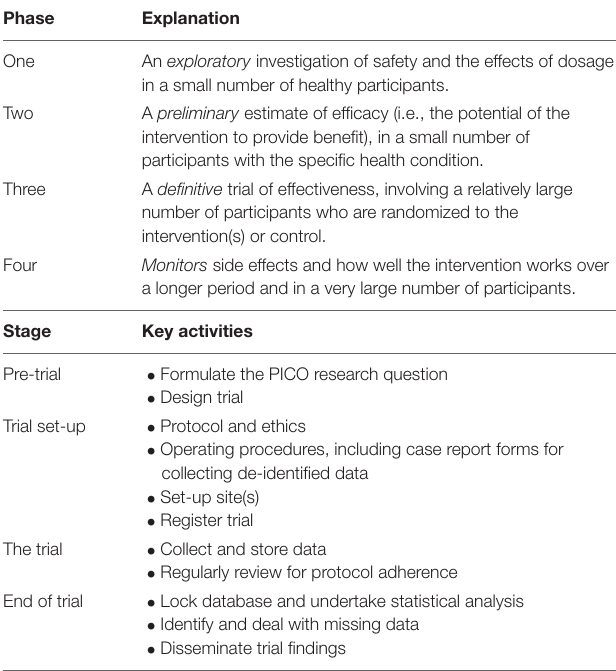
TABLE 1 | Phases (types) of clinical trials and examples of key activities in each clinical trial